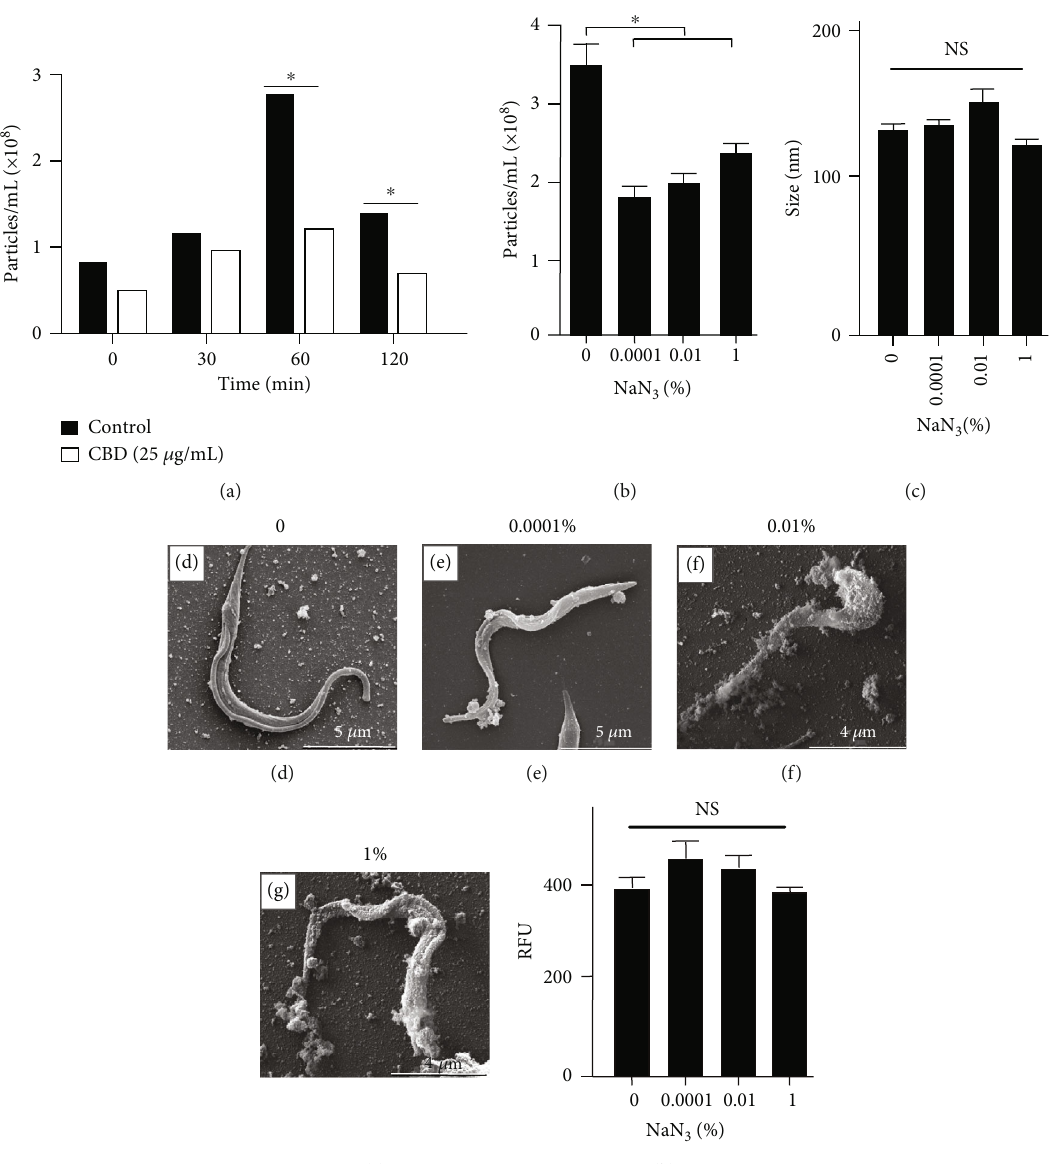
Figure 2: EV release (particles/mL), size (nm), and membrane integrity under chemical stress. Trypanosoma cruzi trypomastigotes were incubated in the absence or presence of methyl-beta-cyclodextrin (CBD) (25 μ g/mL) or NaN supernatant were quanti fi ed by NTA in triplicate ( ∗ p < 0 : 05 ). The panels show EV concentrations (a, b) and size (nm) (c) in the presence of chemical agents. SEM of trypomastigotes preincubated with the indicated concentrations of NaN The relative fl uorescence (RFU) of PrestoBlue viability reagent ( mean ± standarddeviation , n = 3 ) is shown in panel